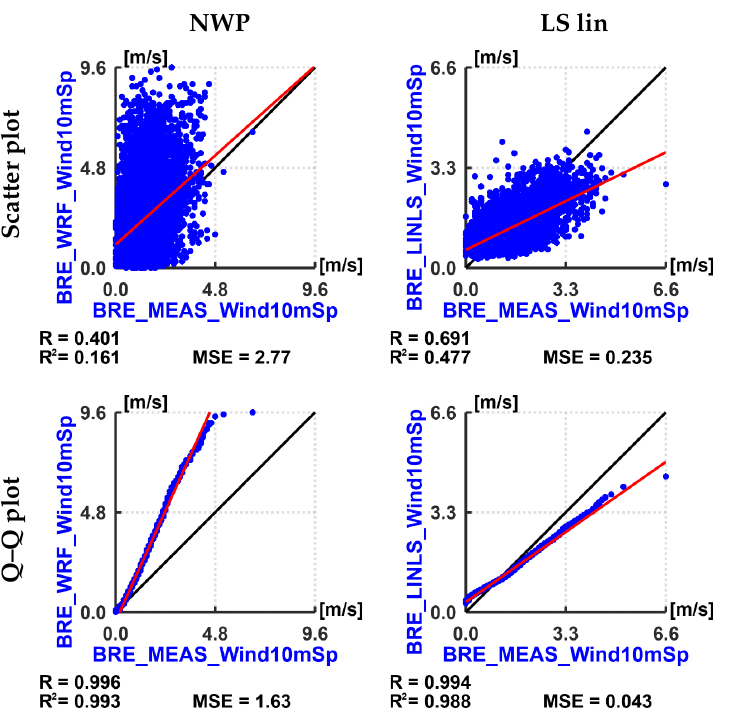
Figure 8. Scatter plots and Q–Q plots of wind speeds for the Brežice meteorological station. The mea- surements are compared to the numerical weather prediction (NWP) model ( left ) and to the linear regression with least squares model trained on November 2017 data ( right ). The experimental model used is the same one as in Figure 6. The shown LS lin model predictions are for the test data. The black line is the line of equality, and the red line is the least-squares linear fit of all the data points.